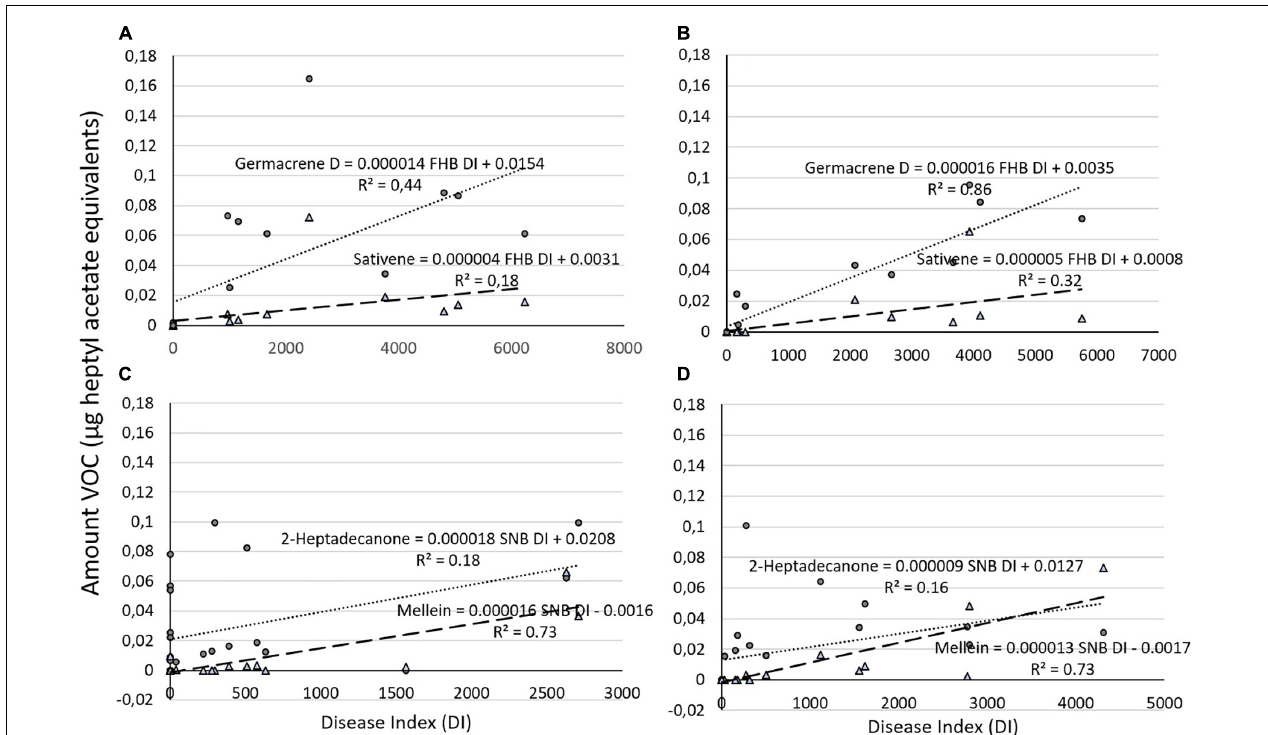
FIGURE 2 | Graphical representation of amount of (A) two different volatile organic compounds (VOCs) (germacrene and sativene) regressed against Fusarium head blight (FHB) DI on ‘Zebra’ and (B) on ‘Bjarne’ and (C) of two different VOCs (2-heptadecanone and mellein) against Septoria nodorum blotch (SNB) DI on ‘Zebra’ and on (D) ‘Bjarne.’ The regression equations and the R 2 values are placed next to the regression lines.